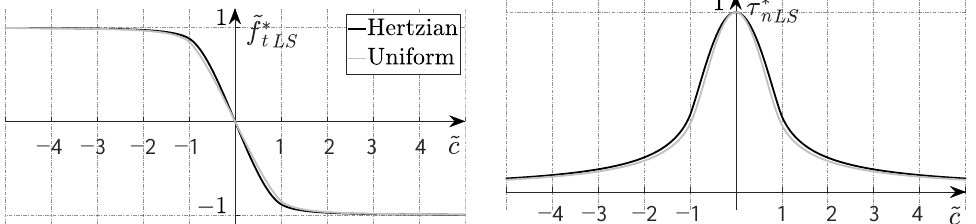
( ˜ c ) and ˜ τ ∗ ( ˜ c ) and their weak variation on the pressure distribu- t LS LS